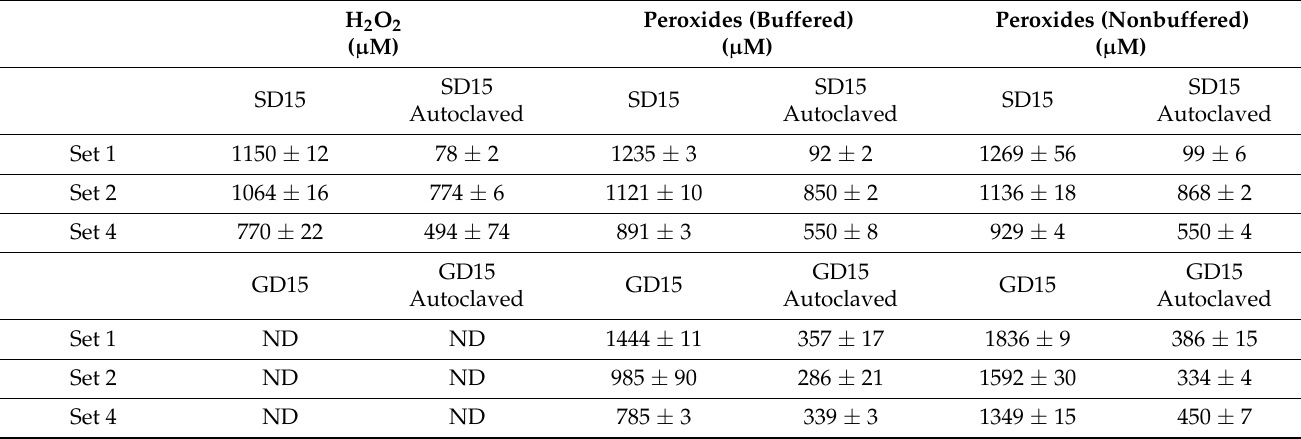
Table 1. Chemical composition of SD15 and GD15 PAW, before and after autoclaving. ND = not detected. Sets 1 and 2 correspond to sets 1 and 2 in Figure 6, set 4 is an additional set (data shown as mean ±